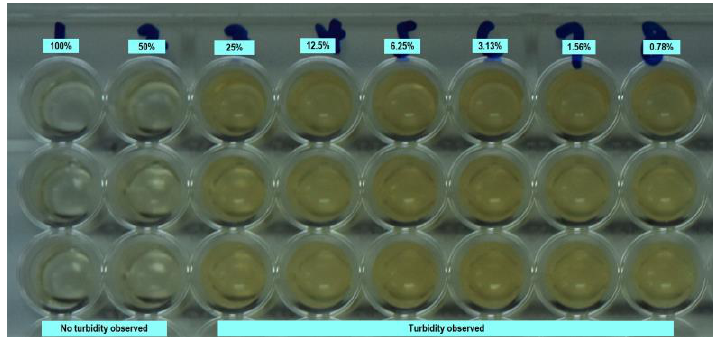
Figure 1. Observation of Enterococcus faecalis growth in a 96-well plate at different concentrations of M-EE fermented for 3 months.